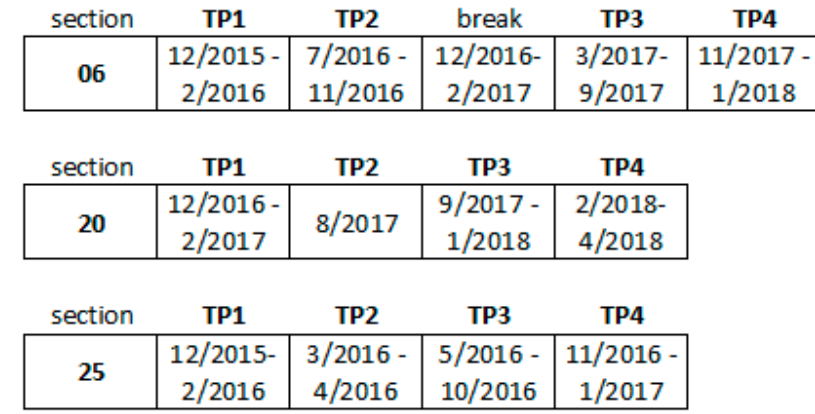
Figure 2. Summary of defined time periods.